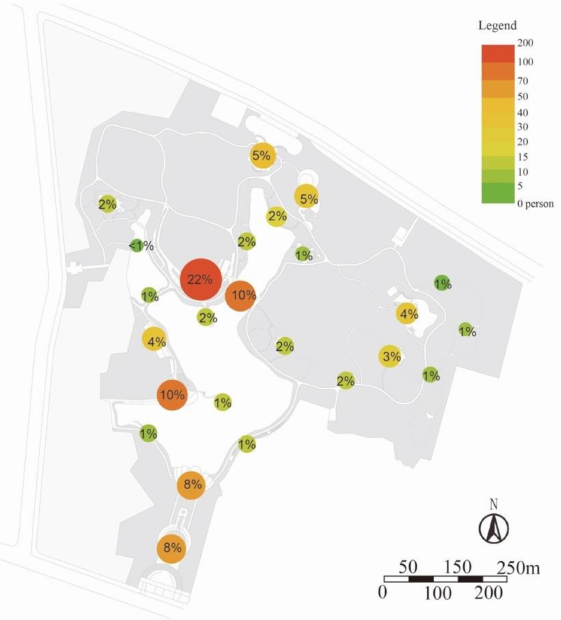
Figure A10. Spatial distribution of average total number of users per hour in Tianhe